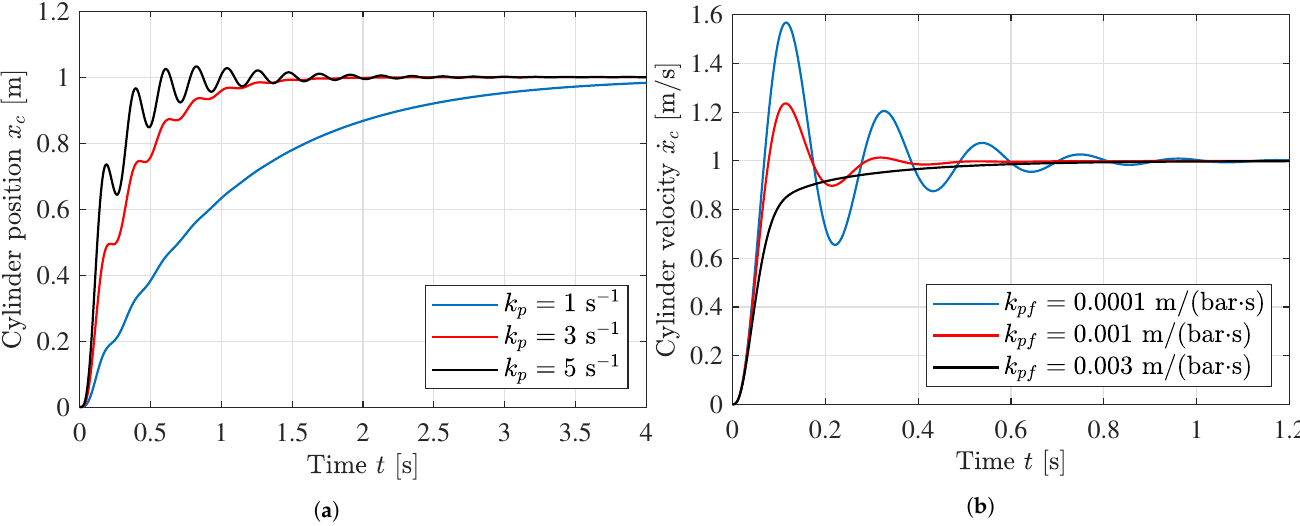
Figure 15. Step responses from the linear models. ( a ) Tuned step responses of k p from Figure 14a; ( b ) Tuned step responses of k pf from Figure